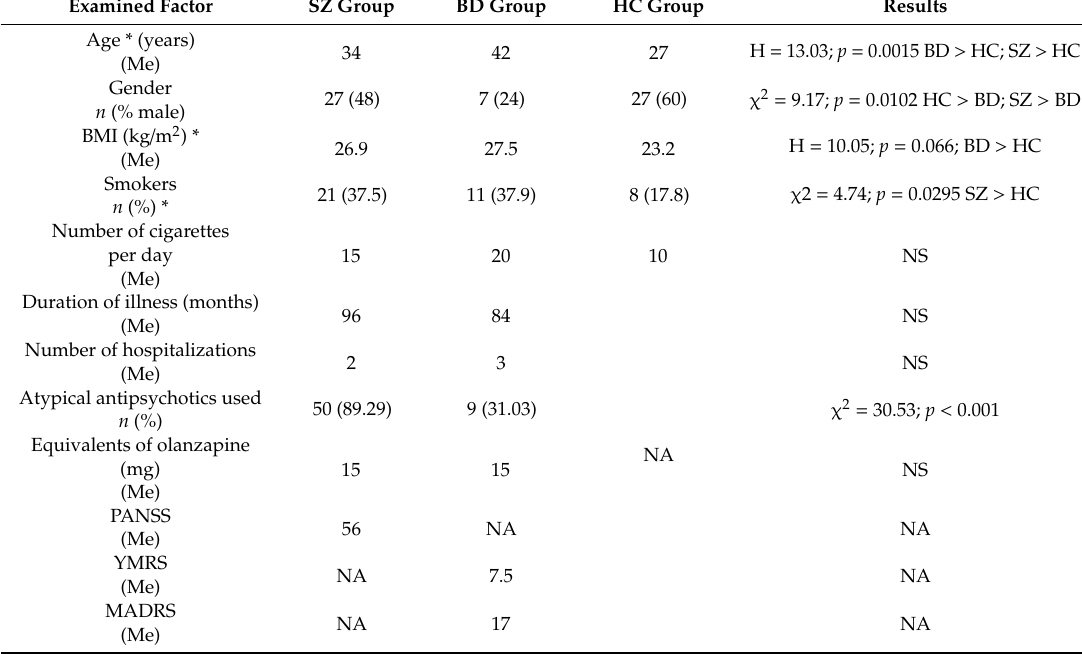
Table 1. Characteristics of the examined